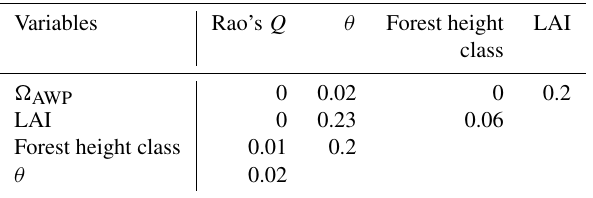
Table A1. Coefficient of determination ( R 2 ) between all used inter- nal forest properties for 370170 stands of the forest factory. θ is the tree height heterogeneity; LAI is the leaf area index; (cid:127) AWP is the species distribution